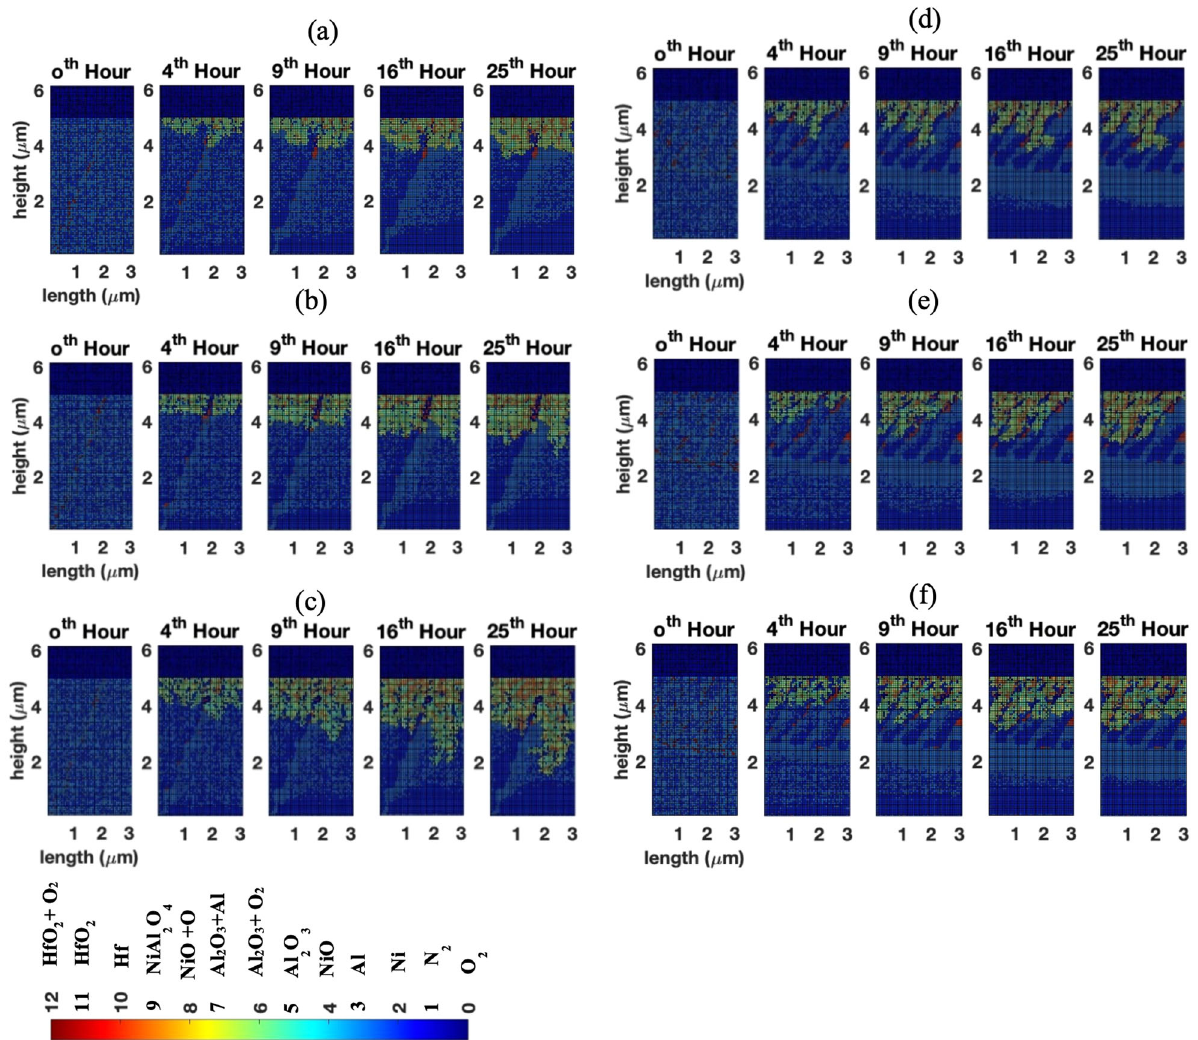
Fig. 8 Microstructure evolution of the oxide scale. a – c Evolution of the oxide scale morphology for a Hf doped bicrystal at 1000, 1050, and 1100 °C, respectively. d – f Evolution of the oxide scale morphology for a Hf doped columnar grain structured alloy at 1000, 1050, and 1100 °C,